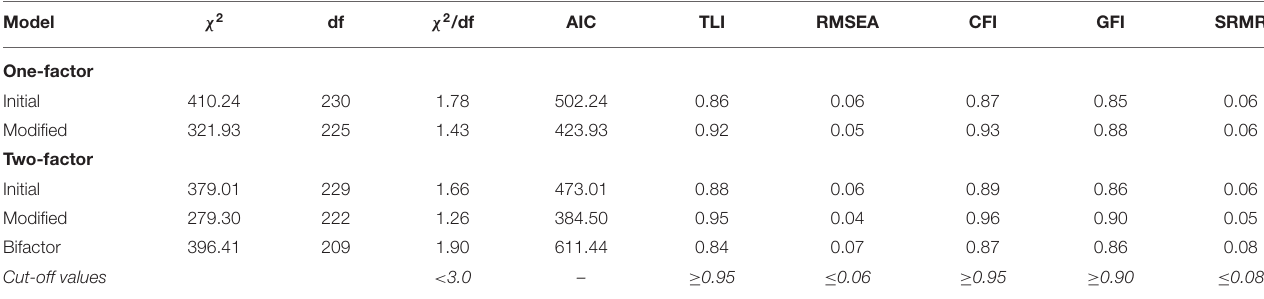
TABLE 2 | Fit Indexes from the confirmatory factor analysis with the counseling competencies scale-revised data.